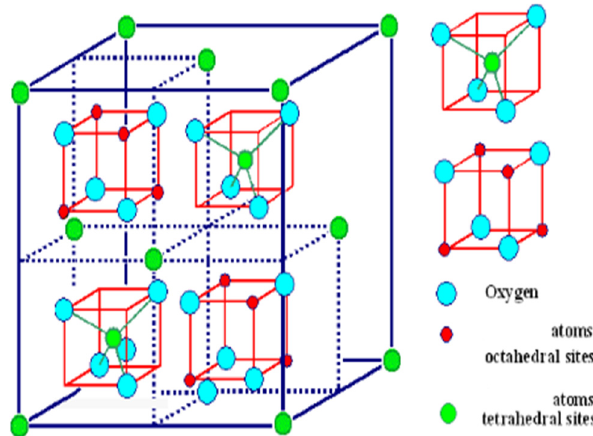
Figure 1. The spinel structure of ferrites is shown indicating the tetrahedral and octahedral